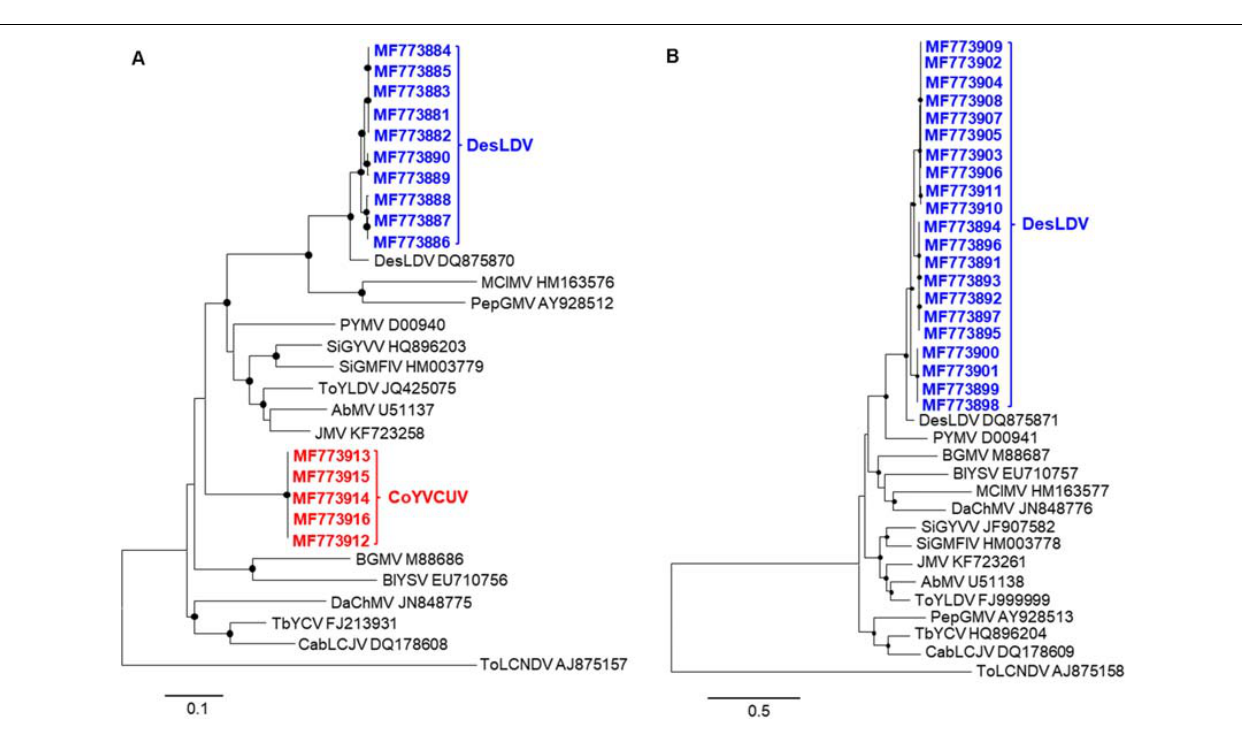
FIGURE 3 | Phylogenetic trees illustrating the relationships of isolates of Desmodium leaf distortion virus (DesLDV) DNA-A (A) and DNA-B (B) (bold in blue) and Corchorus yellow vein Cuba virus (CoYVCUV) DNA-A (bold in red) isolates with other New World begomoviruses. The trees were constructed by the maximum likelihood method (1000 replicates) with the MEGA 7 program using the best fit model, TN93 + G + I for DNA-A and HKY + G for DNA-B. AbMV, Abutilon mosaic virus; BGMV, bean golden mosaic virus; BlYSV, Blainvillea yellow spot virus; CabLCJV, cabbage leaf curl Jamaica virus; DaChMV, Dalechampia chlorotic mosaic virus; JMV, Jatropha mosaic virus; MClMV, melon chlorotic mosaic virus; PepGMV, pepper golden mosaic virus; PYMV, potato yellow mosaic virus; SiGMFlV, Sida golden mosaic Florida virus; SiGYVV, Sida golden yellow vein virus; TbYCV, tobacco yellow crinckle virus; ToYLDV, tomato yellow leaf distortion virus. The Old World begomovirus tomato leaf curl New Delhi virus (ToLCNDV) was used as an outgroup. The bars below the trees indicate the number of nucleotide substitutions per site. Nodes with bootstrap values higher than 50% are marked with filled